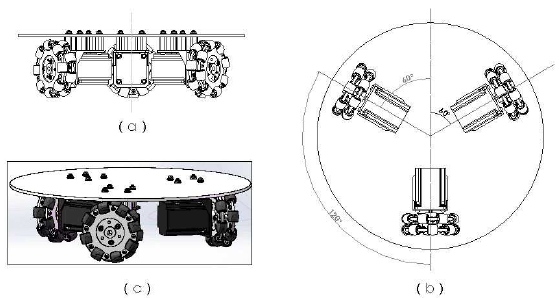
Figure 2. The omni-directional mobile robot (OMR) structure